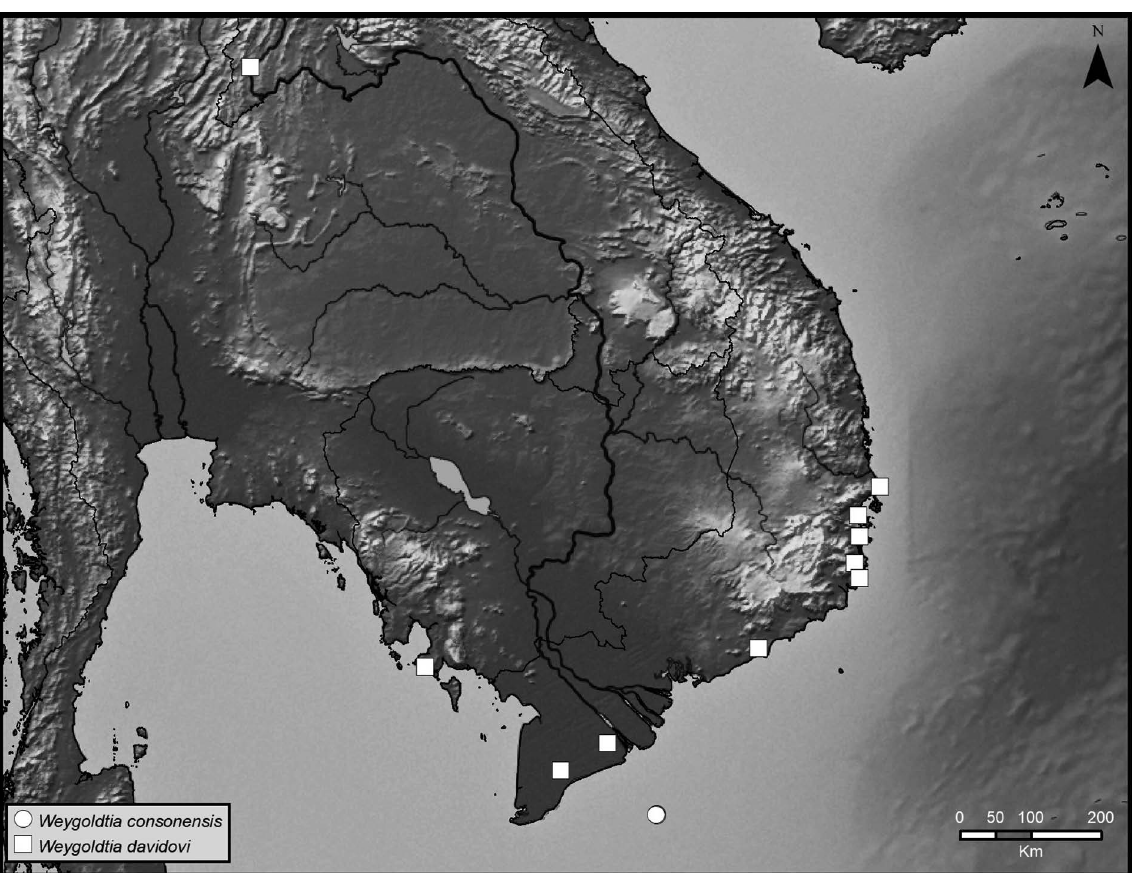
Fig. 150. Map plotting known distributions of species of Weygoldtia Miranda, Giupponi, Prendini & Scharff, 2018 in Cambodia, Laos and